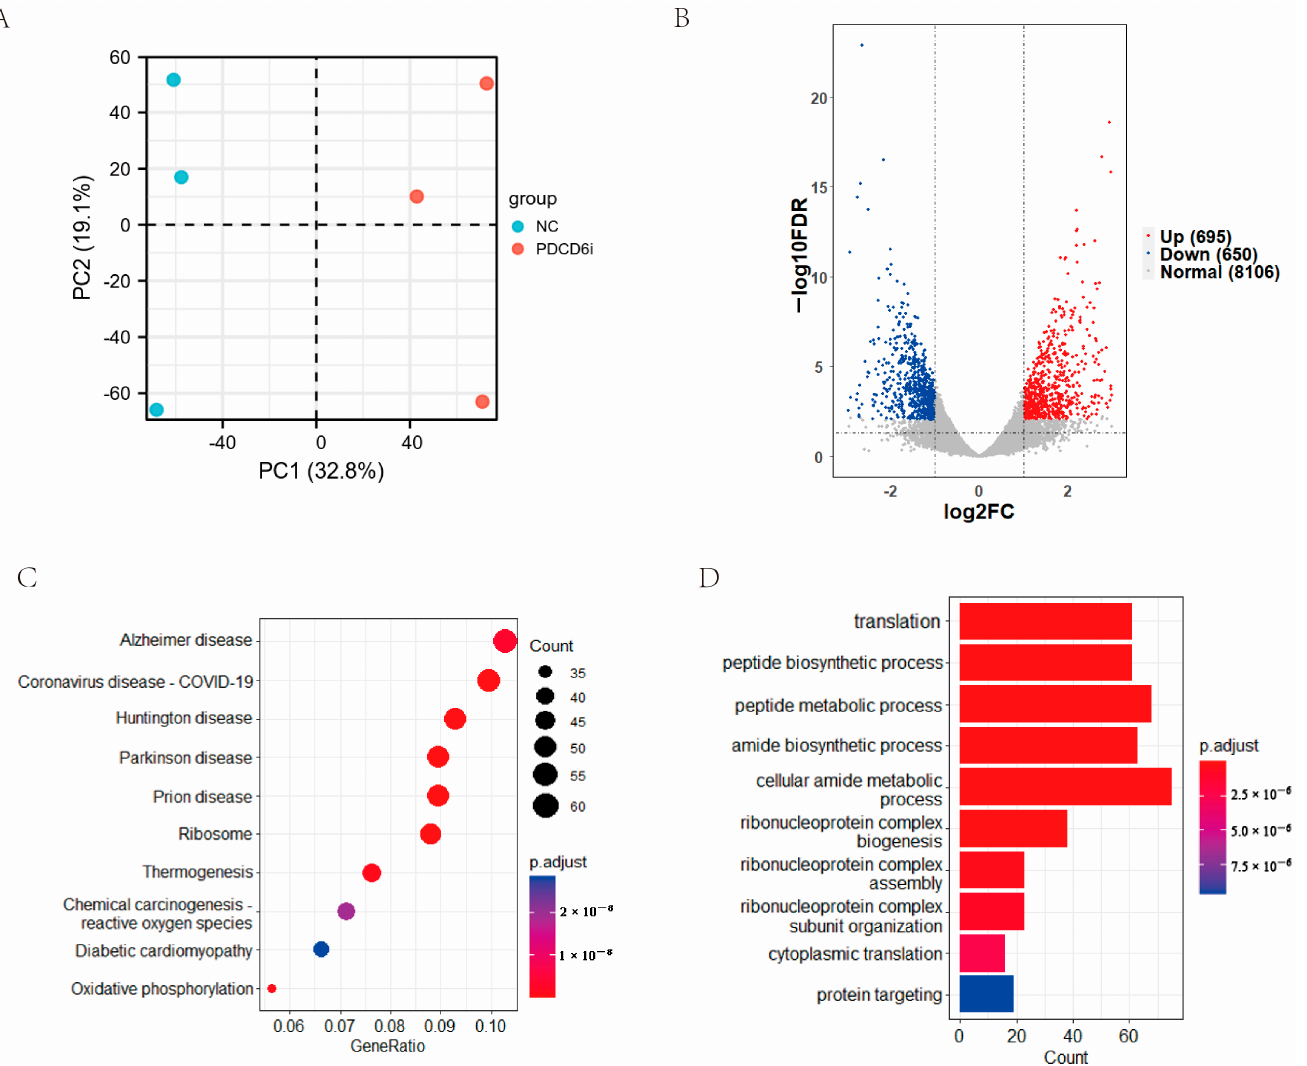
Figure 5. Transcriptomic analysis of two-cell stage SNCT embryos in the PDCD6i and NC groups. ( A ) PCA analysis of the NC and PDCD6i groups. ( B ) Volcano plot of the DEGs between the NC and PDCD6i groups. ( C ) Pathway enrichment analysis of the DEGs based on the KEGG database. The top 10 entries are shown. ( D ) Function enrichment analysis of the DEGs based on the GO database. The top 10 entries are shown.